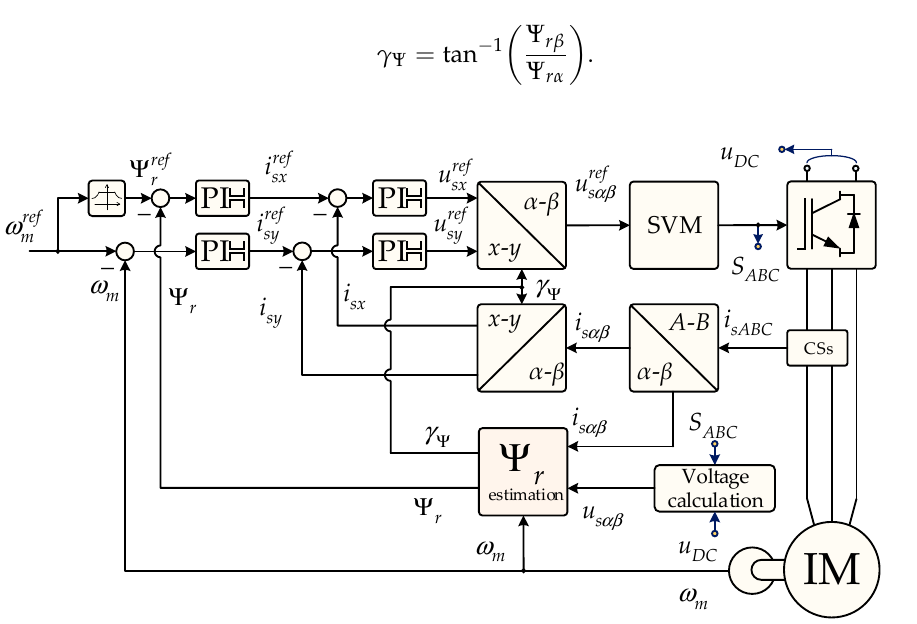
Figure 1. Basic scheme of the DRFOC